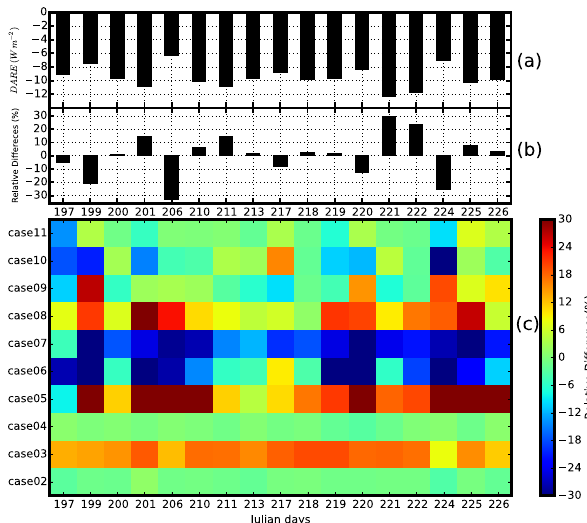
Figure 5. (a) The absolute values of 24h average DARE in Wm − 2 at the TOA for Case 1; (b) the relative differences of DARE values at the TOA of Case 1 compared to its 17-day average; (c) the relative differences compared to Case 1 of different cases for different days at the